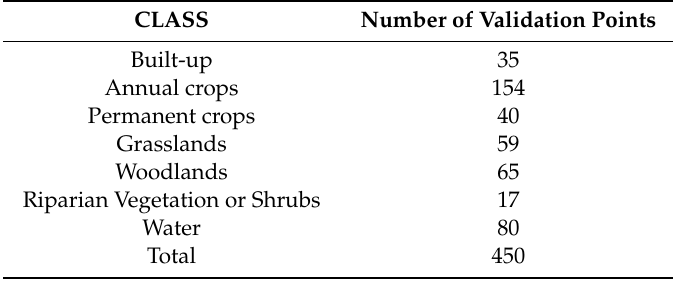
Table 1. The number of validation points for each Land Use–Land Cover (LULC) class.